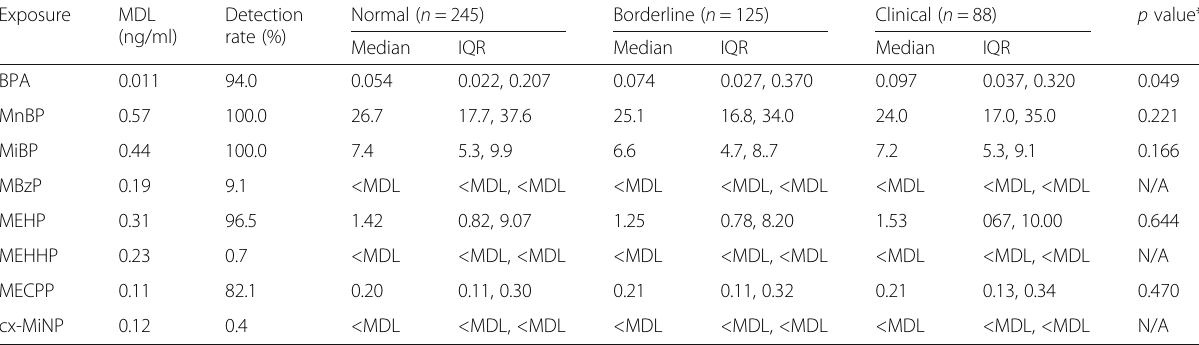
Table 2 Comparison of the distribution of BPA and phthalate metabolite levels in maternal blood of the three groups